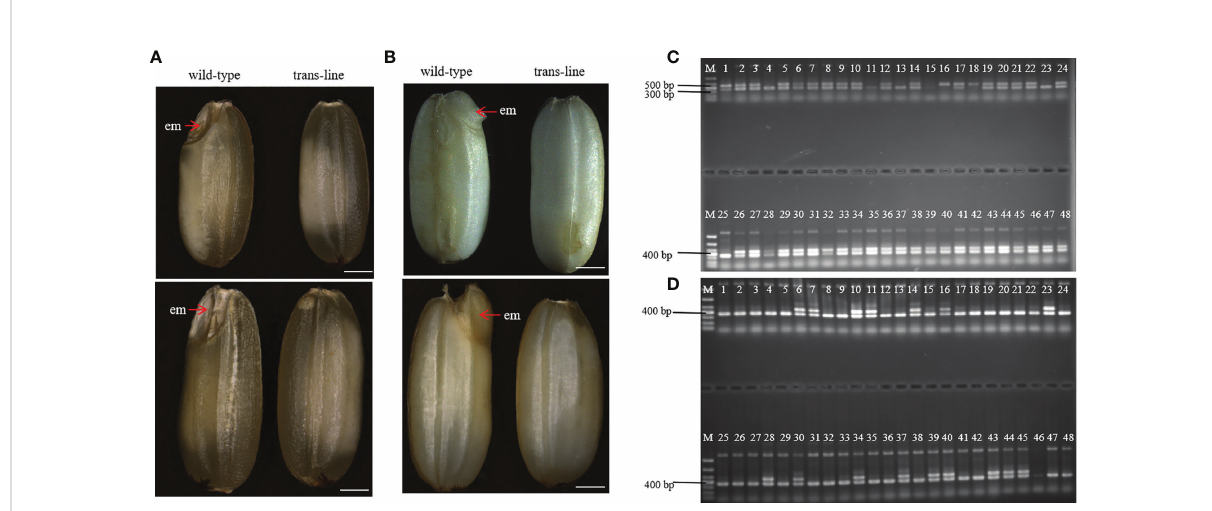
FIGURE 4 Identi fi cation and characterization of embryo-free seeds. (A) embryo-free seeds in trans-line and normal seeds in control wild-type are different in seed phenotype. Normal seeds with the embryo (em; red arrow) in control wild type (n=1000; left), but not in embryo-free seeds (n=59/ 1800; right). Scale bars, 1mm. (B) The embryo is germinated after the pre-germination treatment on normal seeds (left) and nothing changed in embryo-free seeds (right). Scale bars, 1 mm. (C) PCR detection of embryo-free seeds from trans-line, positive transgenic plantlets (lane 1) gave both a 456 bp fragment from AtWUS and a 364 bp fragment from the internal control OSD1 gene. The 456 bp fragment from the AtWUS gene is not present in the control wild-type 9Y genome (lane 25), 91.3% percent of embryo-free seeds are transgene positive in trans-line (n=42/46; lanes 2-24, lanes 26-48). (D) Wild-type 9Y genome(lane 1, lane25) gave just a 364 bp fragment from the internal control OSD1 gene. The 456 bp fragment from the AtWUS gene is ampli fi ed just at the percentage of 34.78% from normal seeds in trans-line (n=16/46; lanes 2-24, lanes